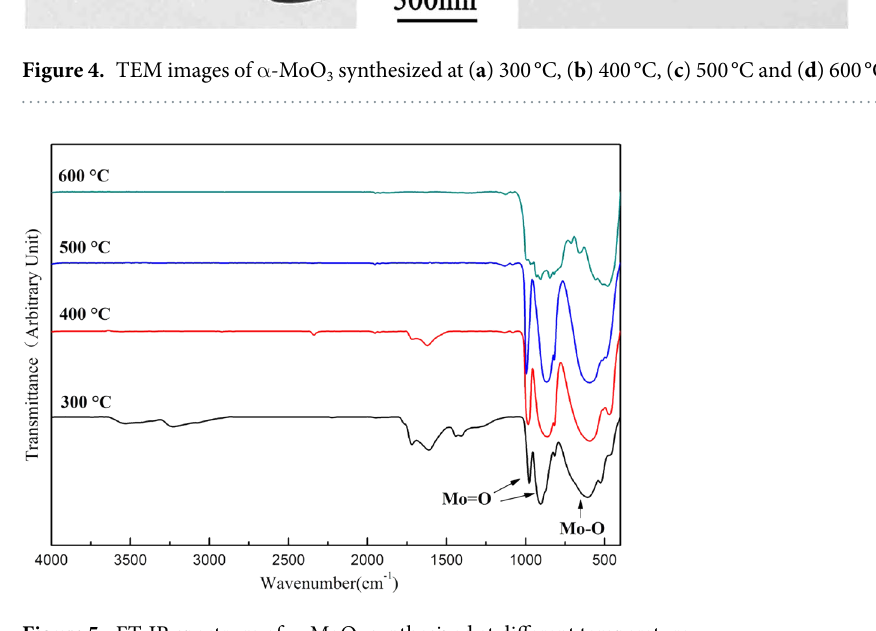
Figure 5. FT-IR spectrum of α -MoO 3 synthesized at different